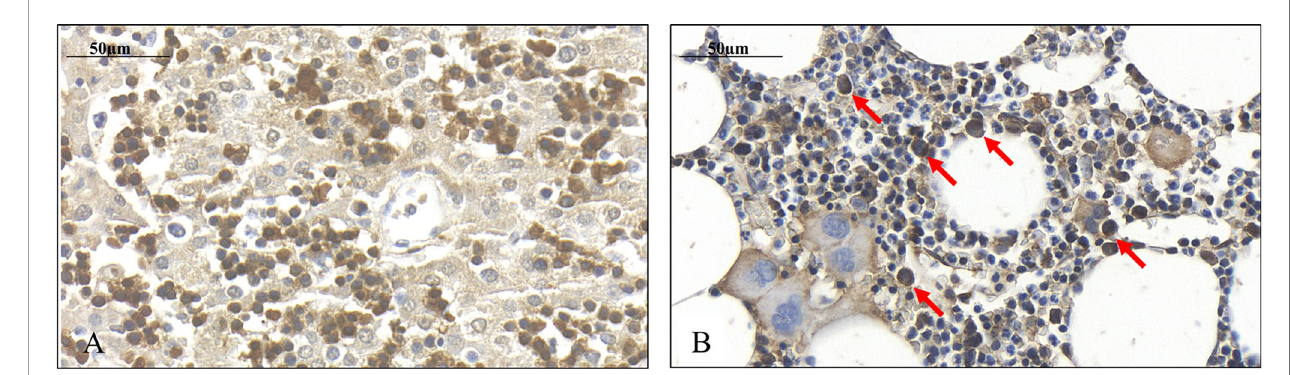
FIGURE 4 | Presence of SPOCK1 in fetal human liver. (A) The weak cytoplasmic staining exhibits a good correlation with SPOCK1 intensity in normal mouse liver; normoblasts in the sinusoids display strong staining. (B) SPOCK1-positive normoblasts are detectable in the bone marrow marked with arrows.